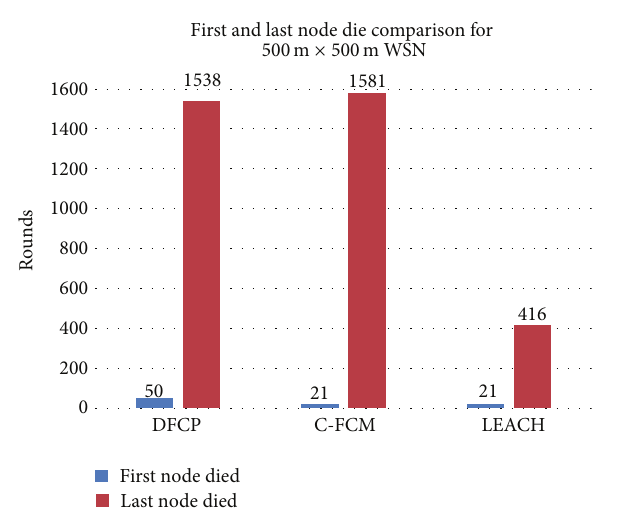
Figure 8: The first and last node die comparison for 500 m × 500 m area